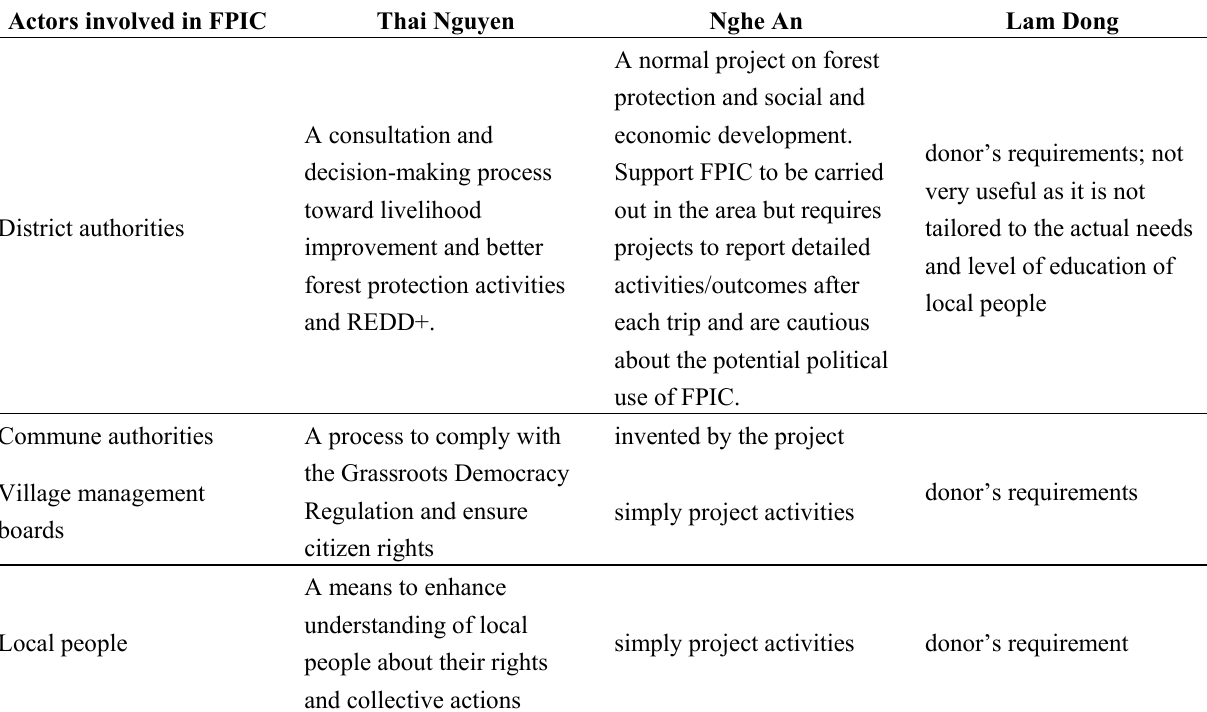
Table 2. Stakeholders’ perceptions on